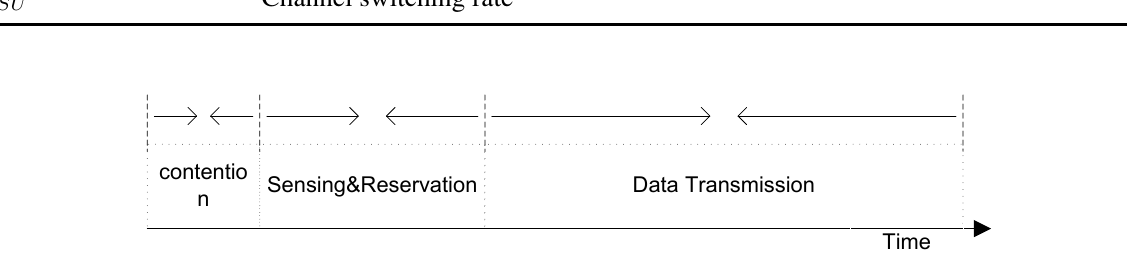
Figure 2. Secondary user (SU) frame